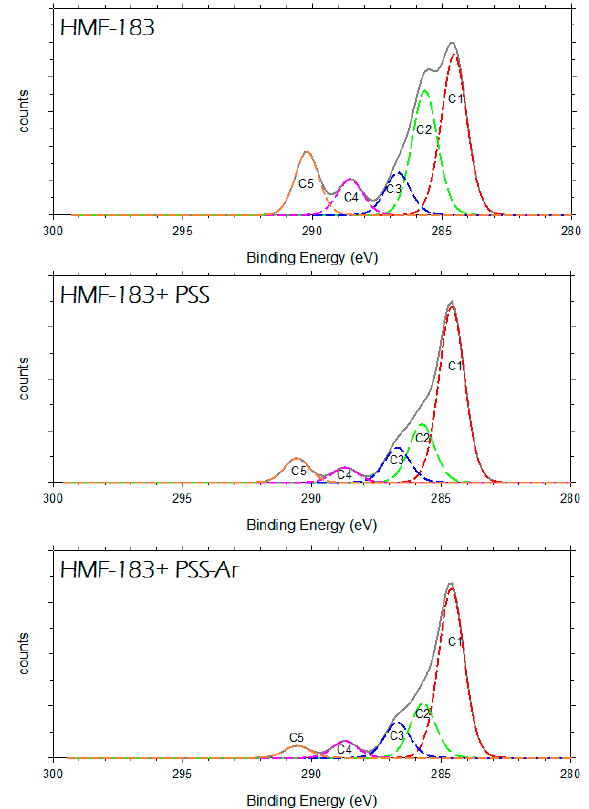
Figure 12. Deconvolution of the C1s peak for the HFM-183, HFM-183 + PSS, and HFM-183 + PSS + Ar